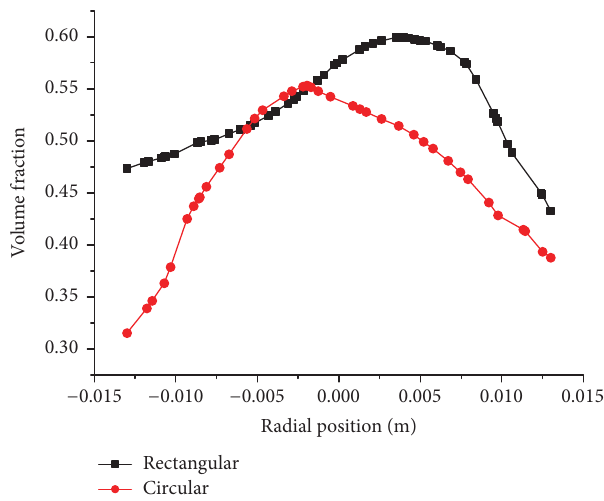
Figure 12: The gas volume fraction distribution on the cross section of the gas phase outlet for two-inlet shape.